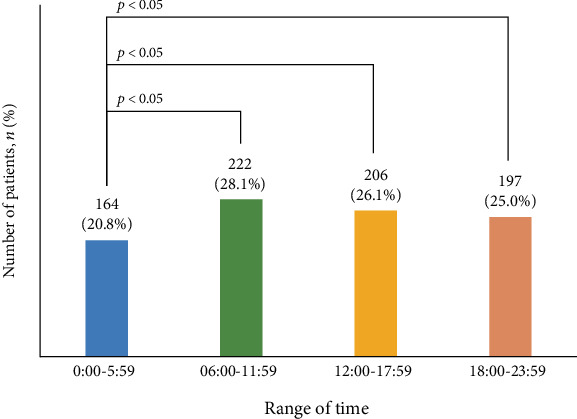
Hypoglycemia-related characteristics of patients who visited the emergency room with hypoglycemia.